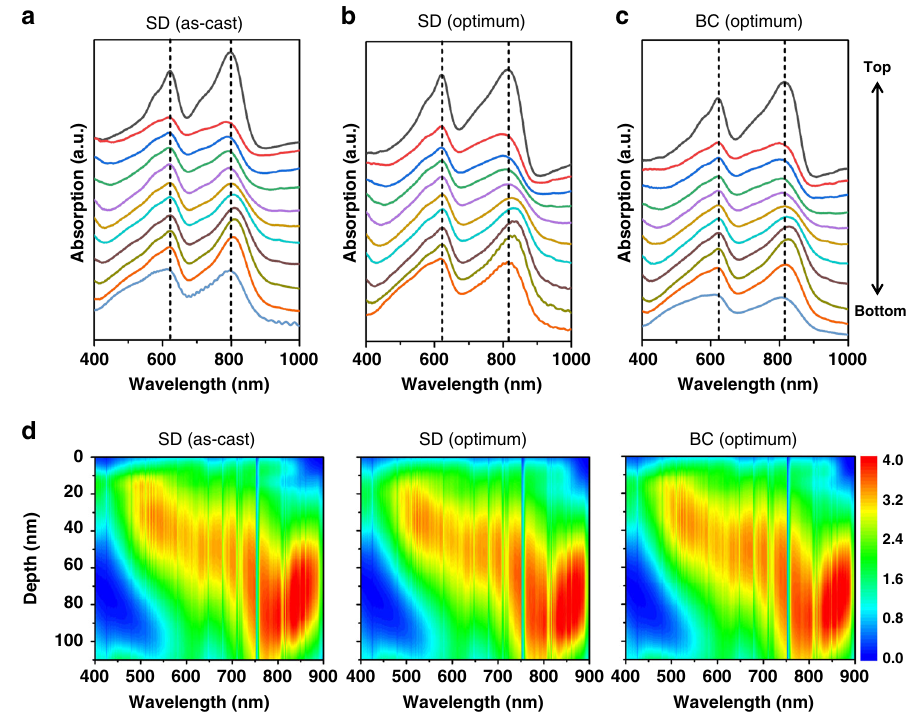
Fig. 2 Film-depth-dependent absorption spectroscopy and exciton generation. a SD (as-cast) fi lm. b SD (optimum) fi lm. c BC (optimum) fi lm. The spectra were vertically shifted and rescaled for clarity. The dashed vertical lines show the absorption peaks of PT2 and Y6. The sub-layer thickness for each spectrum is approximately 10 nm. d Calculated exciton generation contours (unit, 10 25 m − 3 ·s − 1 ·nm − 1 at its fi lm-depth and wavelength) from a to c , respectively. The noise-like vertical lines in the contours are from the real fl uctuation of solar spectra (AM 1.5 G). 0 nm and 110 nm represent active layer/ PNDIT-F3N-Br and PEDOT:PSS/active layer interfaces,